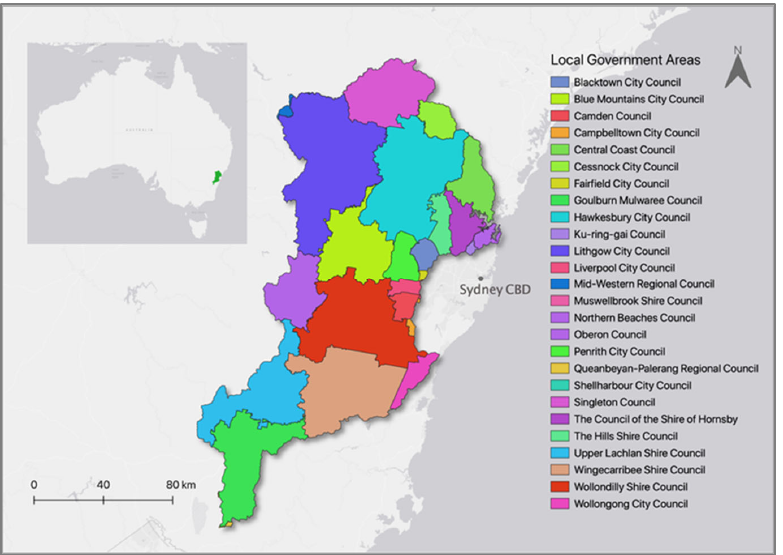
Figure 1. Local government areas located within the Hawkesbury ‐ Nepean catchment as of 2022.